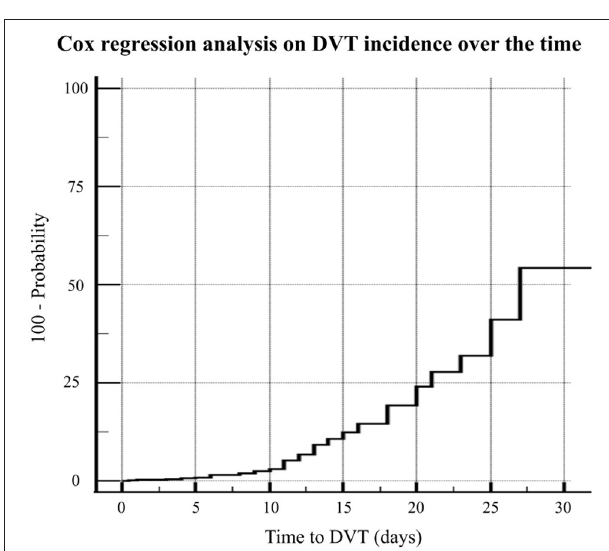
FIGURE 4 | The Cox proportional-hazard regression analysis including eight different factors potentially associated to time-to-DVT event (i.e., age, sex, BMI, SOFA score, comorbidities, anticoagulation intensity, d-dimer level, length of ICU